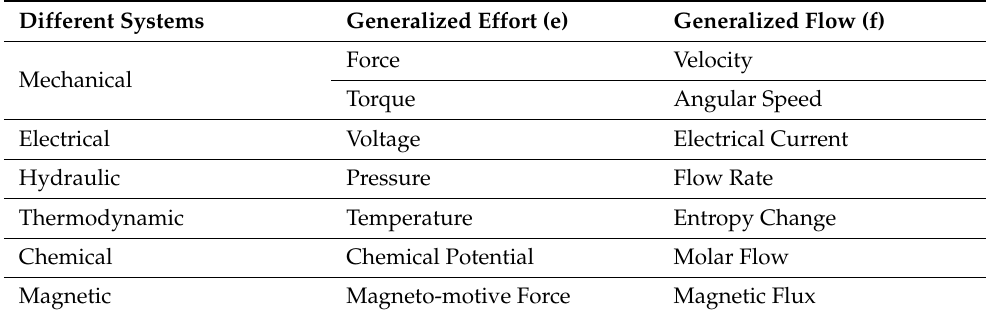
Table 1. Physical systems. Different